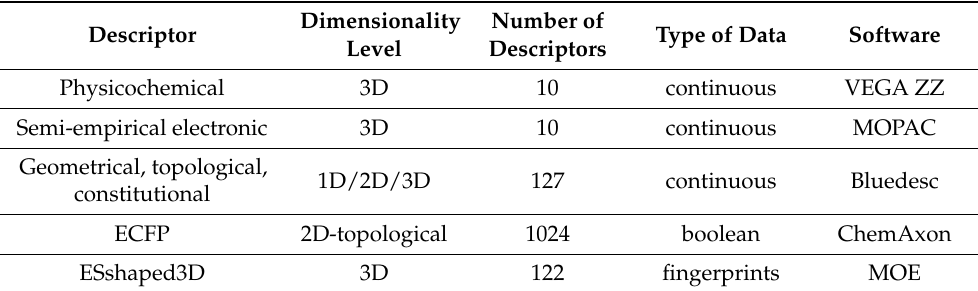
Table 4. Sets of descriptors used in the study with their dimensionality, the number of computed descriptors, the type of data, and the utilized software. The ESshaped3D fingerprints were used only for the applicability domain